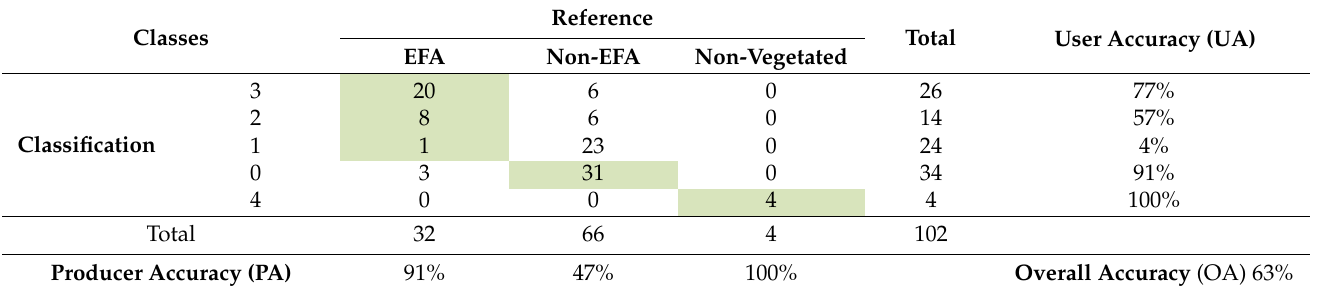
Table 3. Confusion matrix computed for the EFA map with reference to the VP dataset. Matrix elements contain the number of fields satisfying local conditions. Green cells are those used to compute OA.